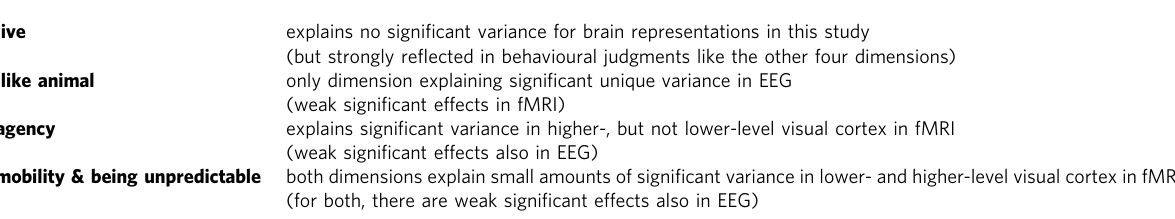
Table 1 Summary of fi ndings. being